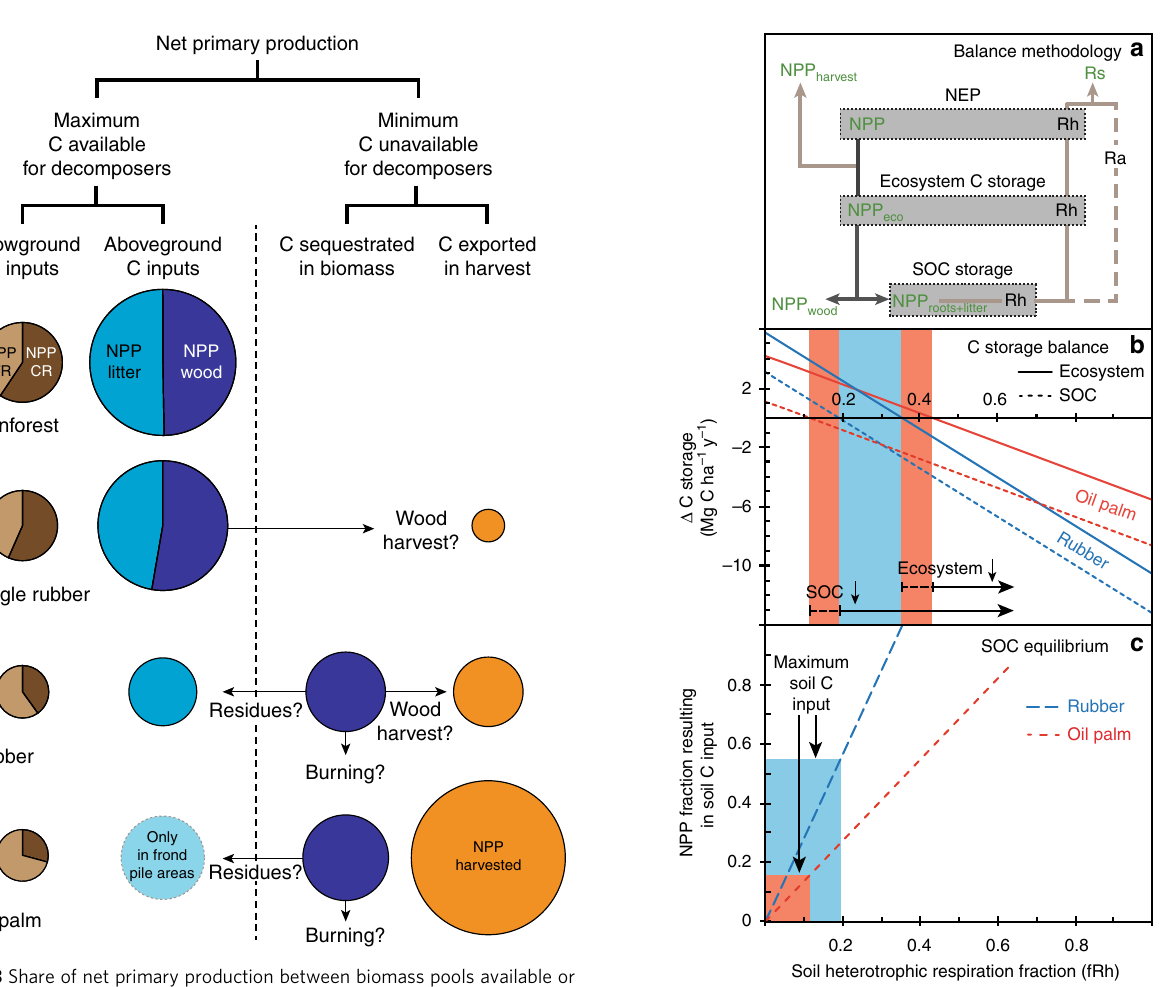
Fig. 4 Changes in ecosystem and soil organic carbon storage depending on soil heterotrophic respiration. a Summary of the fl uxes that must be balanced to estimate net ecosystem productivity (NEP), ecosystem C storage, and soil organic C storage (SOC). Fluxes in green were measured, i.e., litter, fi ne, and coarse root production (NPP roots + litter ), wood production (NPP wood ), the sum of the previous fl uxes (NPP eco ), the harvest (NPP harvest ), the total net primary production (NPP) and soil CO 2 ef fl ux (Rs). Balances depend on the contribution of heterotrophic (Rh) and autotrophic (Ra) respiration in Rs. b Ecosystem (solid lines) and soil organic carbon (SOC, dashed lines) balances in rubber and oil palm plantations depending on the fraction of soil heterotrophic respiration (fRh) in soil CO 2 ef fl ux. Blue and orange areas correspond to fRh in, respectively, rubber and oil palm plantations at which ecosystem C storage would increase despite a decrease in SOC stocks. Soil organic C stocks balances were calculated for maximum soil C inputs. c Fraction of heterotrophic respiration at which SOC pool would be at equilibrium depending on actual soil C inputs (expressed as fraction of NPP eco ) in rubber (blue) and oil palm plantations (orange). Maximum soil C input corresponds to NPP roots in oil palm plantations outside frond piles and, additionally, NPP litter in rubber plantations if coarse and fi ne roots biomass pools in mature plantations